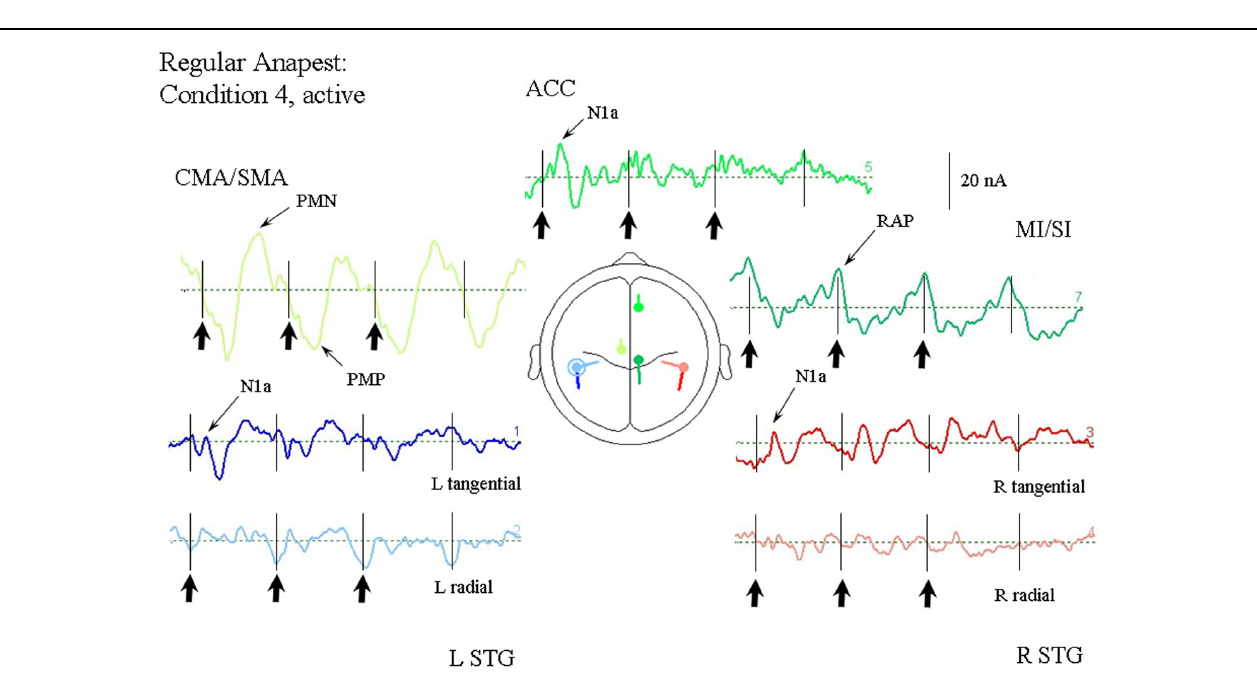
enhanced activity in all sources. The ACC source again shows a CNV prior to the third beat, but then a large contribution to the N1a followed by an earlier P300 (labeled P3a). The STG sources all show enhanced activity at around the N1 wave. A P300 can also be seen in the STGr sources accompanied by an N300 in the CMA/SMA source.